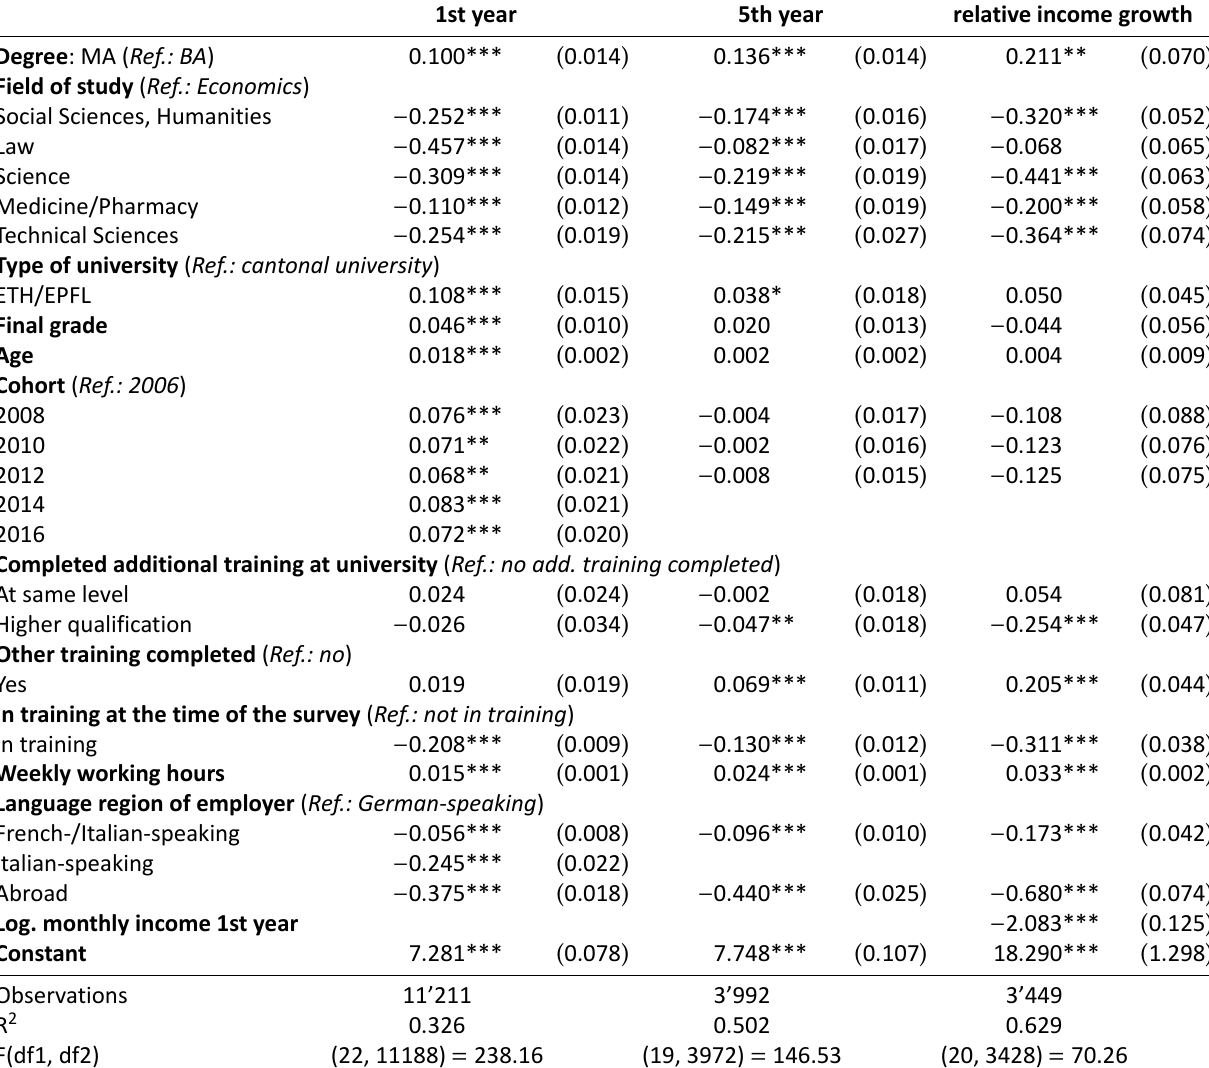
Table A8. Women’s monthly income (log.) in the 1st and 5th year after graduation and relative income growth; OLS-models. 1st year 5th